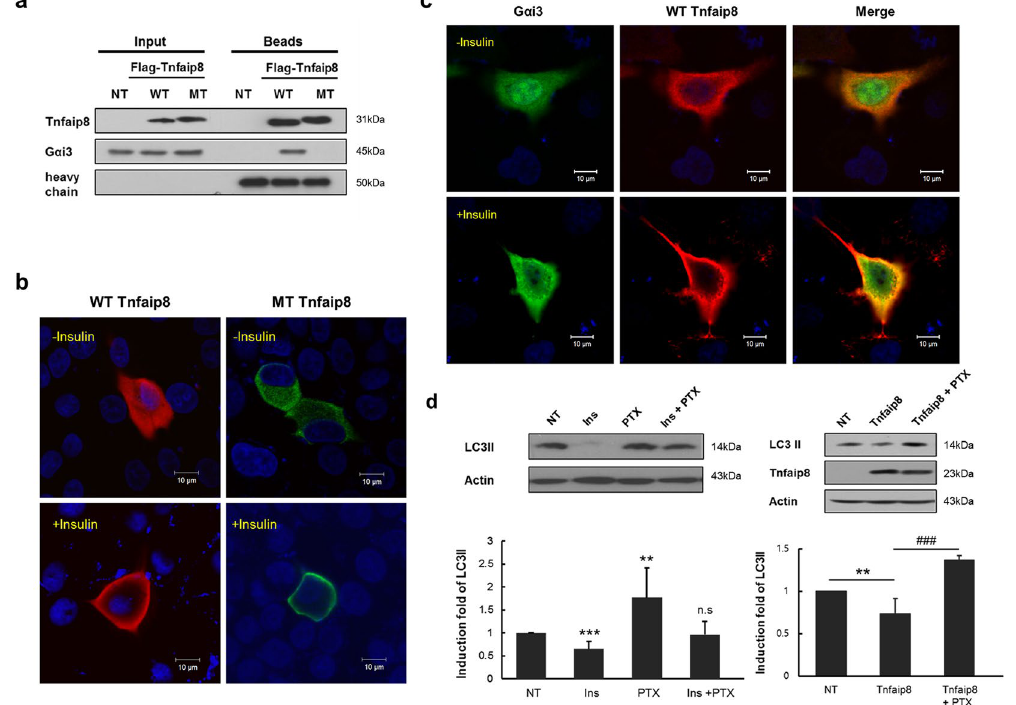
Figure 7. Interaction between wild-type mTnfaip8 and the triple mutant with G α i3. ( a ) Co- immunoprecipitation assay using Flag-tagged wild-type mTnfaip8 (WT) and the Flag-tagged mTnfaip8 triple mutant (MT) was performed in Hepa 1-6 cells as described in Materials & Methods. As expected, the mTnfaip8 triple mutant with PE deficiency barely interacted with G α i3, whereas wild-type mTnfaip8 maintained normal interaction with G α i3. ( b ) HepG2 cells were transfected with Flag-mTnfaip8 (WT, red) and Flag-mTnfaip8 triple mutant (MT, green), followed by insulin treatment. Their subcellular relocalization was monitored by confocal microscopy. Representative images are shown here. Both cytoplasmic wild-type and mutant Tnfaip8 appeared to be relocated very significantly to plasma membrane by insulin treatment. ( c ) HepG2 cells were transfected with Flag-mTnfaip8 (WT, red) and myc-G α i3 (green), followed by insulin treatment. The prominent relocation of both cytoplasmic mTnfaip8 and G α i3 to plasma membrane after insulin treatment was observed. Representative images are shown here. ( d ) Treatment of Pertussis toxin (PTX) (100 ng/ml) was able to inhibit significantly insulin-induced anti-autophagy as demonstrated by the increased levels of LC3II (left panel). Moreover, anti- autophagic effect of Tnfaip8 overexpression was also inhibited by the PTX treatment (right panel). Values are means (SD). ** p < 0.01 and ### p/ *** p < 0.001. The full-length blots are presented in Supplementary Figure 4 (Fig.